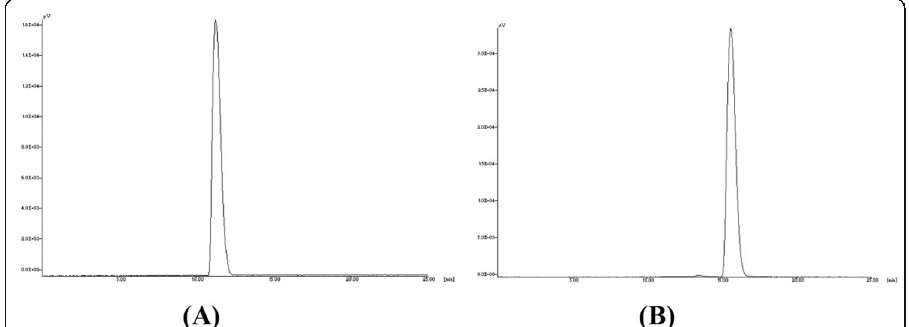
Fig. 1 HPLC chromatograms of MUC1-[ 18 F] SFB peptide (A) and MUC1-FA-[ 18 F] SFB hybrid peptide conjugates